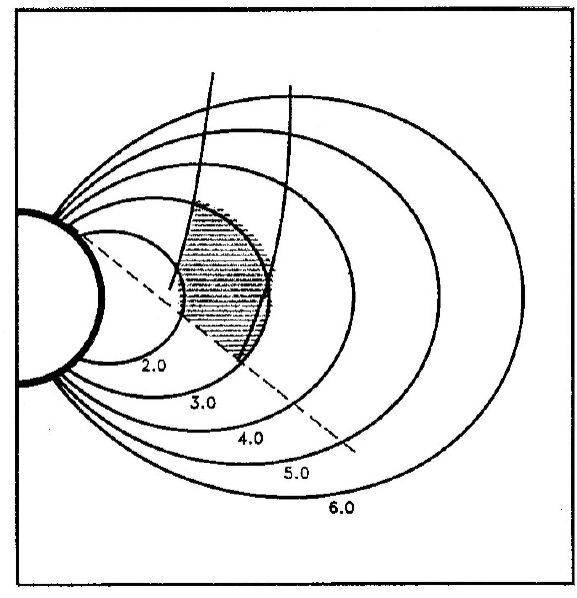
Fig. 4. Parts of MAGION 4 orbits, the lowest and the highest ones, on which magnetospherically reflected whistlers were ob- served. Dashed line is the limit of real time telemetry zone of the Pansk´a Ves station where the analog broadband signal 0.1–22 kHz was recorded. The region of MR whistler occurrence is denoted by